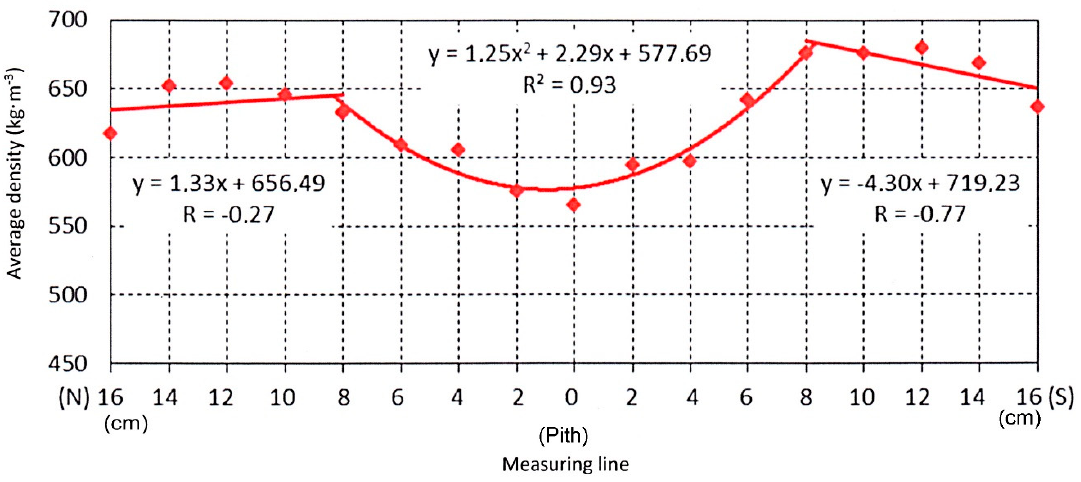
Figure 5. Distribution of average densities on the cross-section of a birch log at ¼ of the log height.